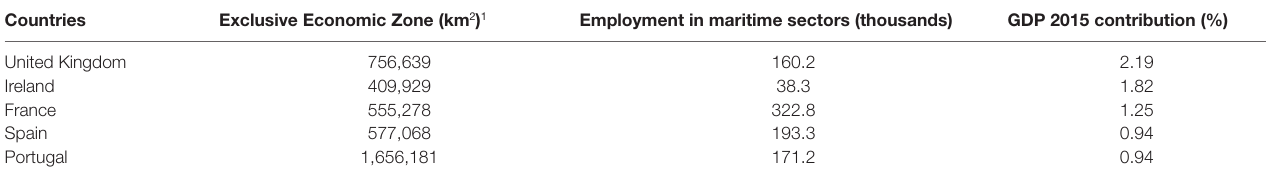
TABLE 1 | An overview of the geographical and socio-economic boundary conditions for NEAA countries, including their EEZ portion (in km 2 ), employment (from 2007- 2019) in the maritime economy (thousands of people) and contribution of the Blue Economy to the GDP (%) (Calado et al., 2019).